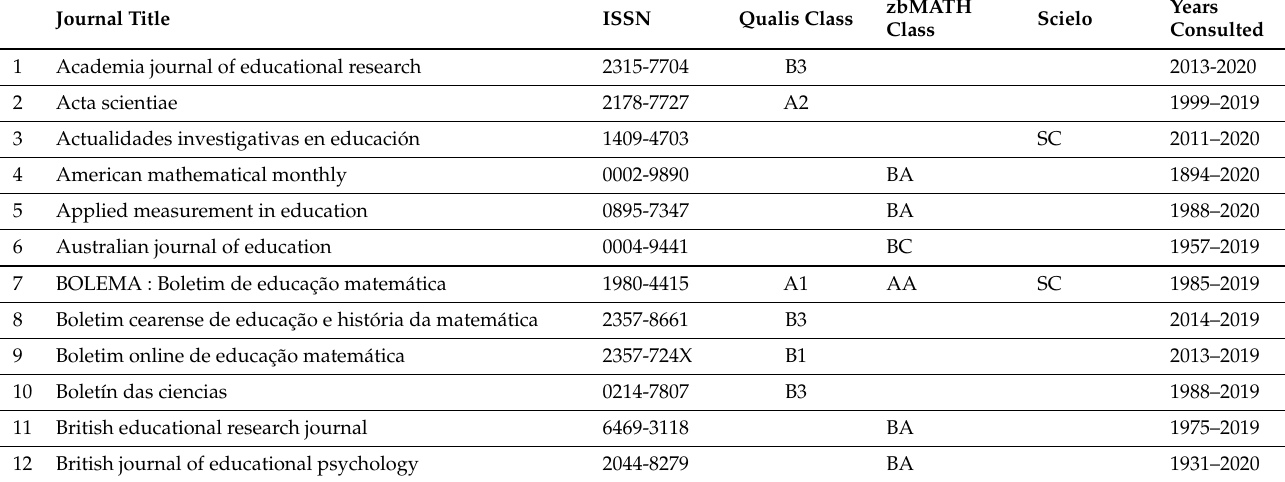
Table A1. List of journals from Qualis, zbMATH, and Scielo database. The notation A1, A2, B1, B2, B3, B4, B5, and C are the classification of Qualis. The notation AA, AB, and AC (or BA, BB, and BC) are used for journals considered in the Serie A (or Serie B) and types A, B, and C (or A, B and C) in the classification given by [46]. The “Journal code” is a abbreviated reference code of the corresponding journal which is introduced by citation